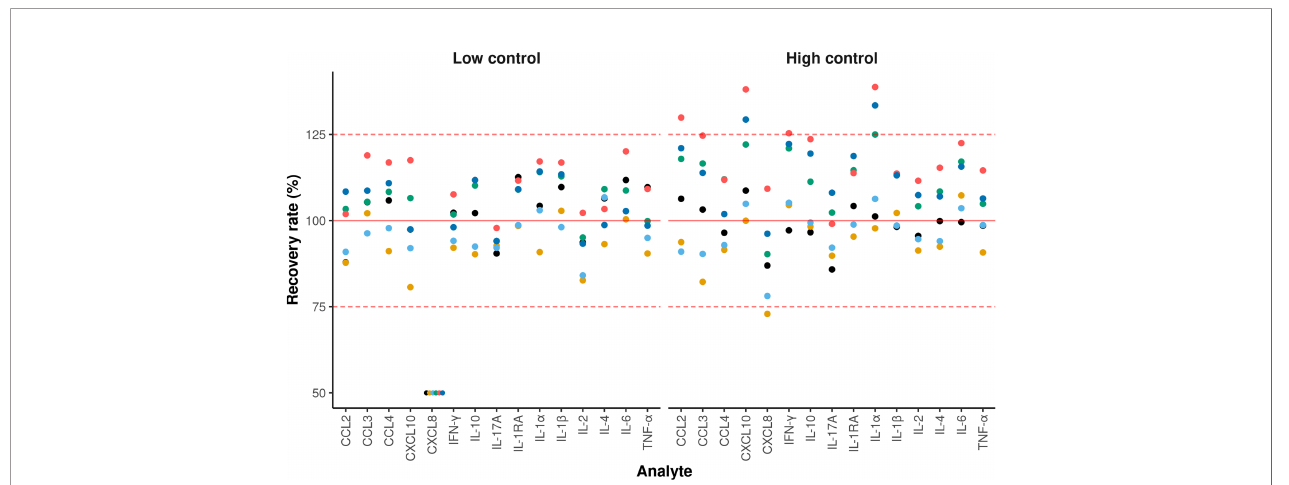
FIGURE 2 | Recovery rates for each cytokine. The x and y-axis represent the analytes and the recovery rate, respectively. Each dot represents the recovery rate of a given plate. The solid red line indicates a 100% recovery rate. A recovery rate is considered correct when the value is between 75 and 125% (dashed red lines). For display purposes, all the samples having a recovery rate of less than 50% were set to 50%. Each color corresponds to one of the six plates containing control